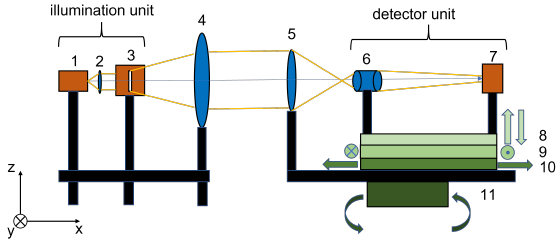
Figure 1. Schematic depiction of the MTF measuring setup [4]: 1) Fibre coupled led light source (Schott KL 2500), 2) optical system comprising a di ff usor, condensor and wavelength filter ( λ ≈ 546nm), 3) object slit, 4) optical collimator D c = 110mm, f = 1100mm, 5) sample mount, 6) microscope objective for fi- nite imaging, 7) camera detector, 8) z-positioner, 9) y-positioner, 10) x-positioner, 11) rotation axis to assign di ff erent field